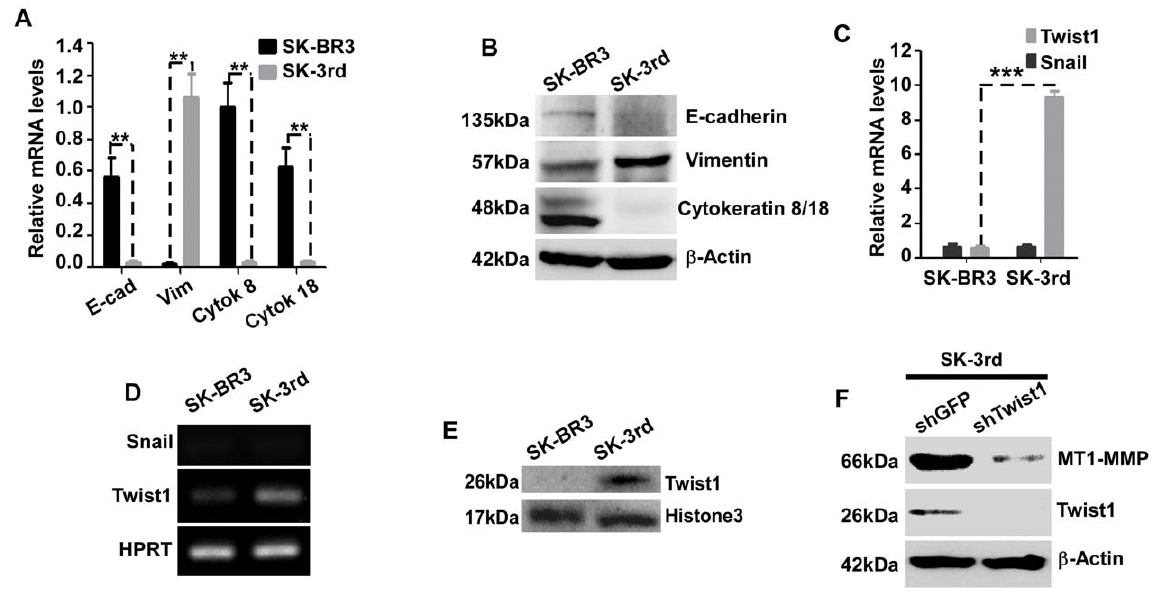
Figure 5. SK-3rd TICs possess properties of EMT. A–B) Differential expression of EMT markers in SK-3rd TICs: SK-BR3 and mammosphere forming SK-3rd cells were examined by real time RT-PCR (A) and Western blotting (B) for expression of EMT markers. E-cad: E-cadherin; Vim: Vimentin; Cytok: cytokeratin. C–E) Upregulation of Twist-1 in SK-3rd TICs: The total RNA of SK-BR3 and SK-3rd cells was examined for expression of Twist-1 and Snail using real time RT-PCR (C). Housekeeping genes were used to normalize Twist-1 and Snail mRNAs in all samples. At the end of real time RT-PCR, the samples were examined in a 1.2% agarose gel (D). The cell lysates from nuclear fractions were examined by Western blotting using anti-Twist-1 antibodies (E, Upper panel). Histone 3 was used as a loading control for nuclear preparation. F) Effect of Twist-1 on MT1-MMP expression: SK-3rd TICs silenced for Twist-1 or GFP control were examined by Western blotting using antibodies as indicated for expression of MT1-MMP and Twist-1. b -actin was used as a loading control.